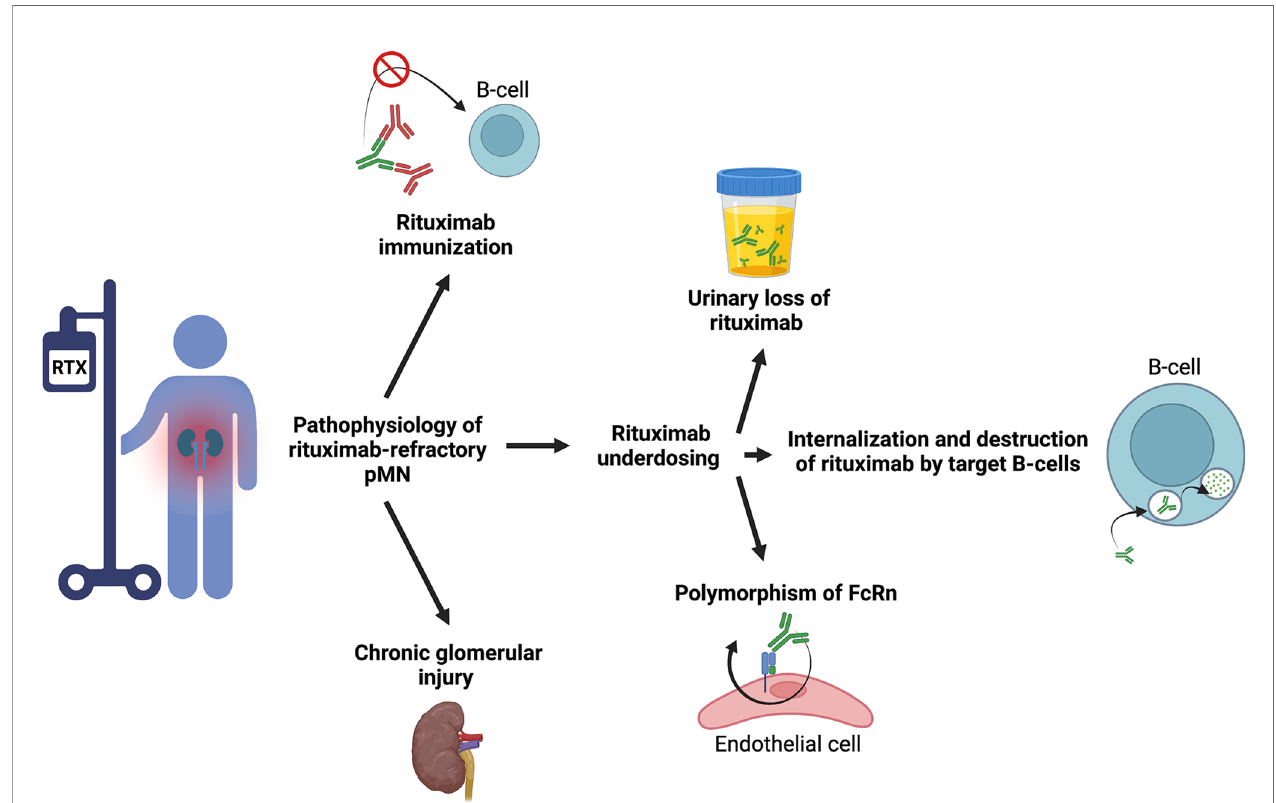
FIGURE 2 | Main causes of rituximab resistance in membranous nephropathy. ADAs, anti-drug antibodies; FcRN, neonatal Fc receptor for IgG; PLA2R1, phospholipase A2 receptor type 1; RTX, rituximab. Figure created with